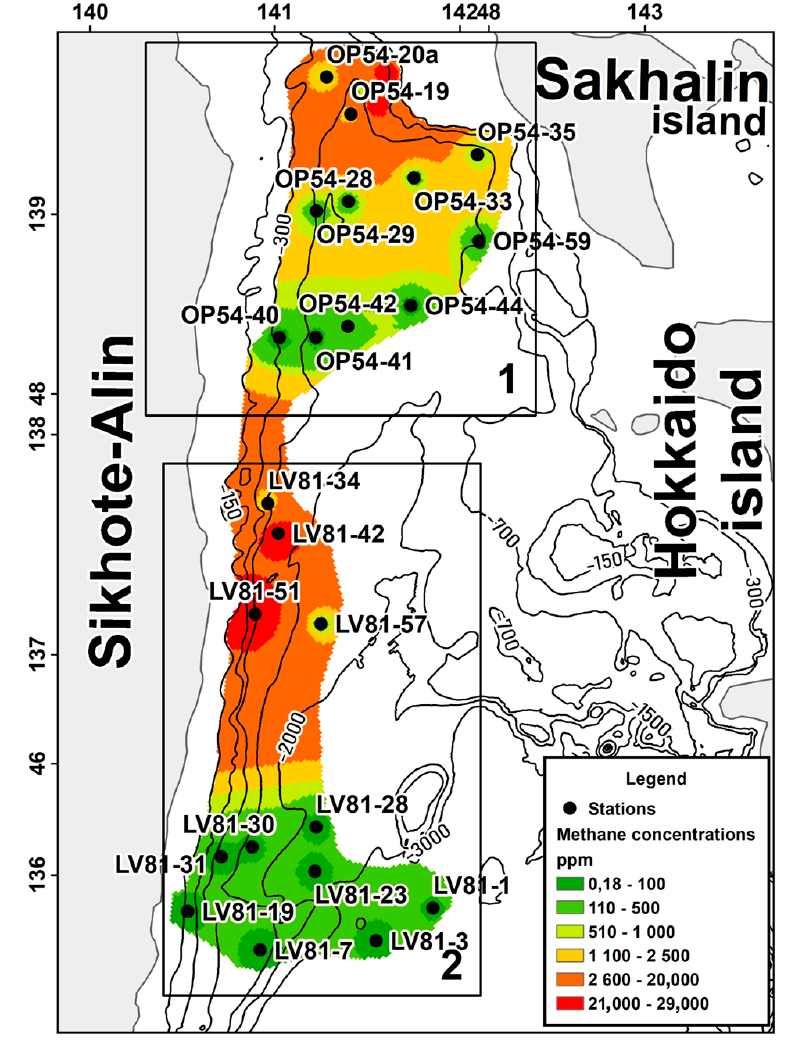
Figure 1. Study area. Methane content (ppm) in bottom sediments of the studied areas of the northern part of the Sea of Japan. (1) Gas-hydrate area; (2) non-gas-hydrate area. The average concentration of methane in the non-gas-hydrate area is significantly higher than the same indicator in the gas-hydrate area. In addition, the non-gas-hydrate region is deeper than the gas-hydrate